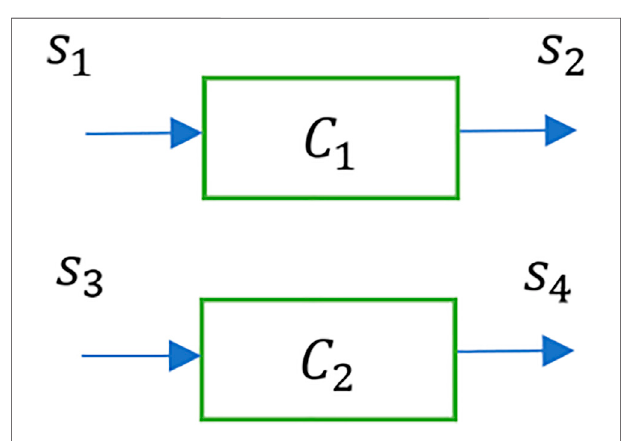
FIGURE 11 | Composition of a sheaf of parallel chains